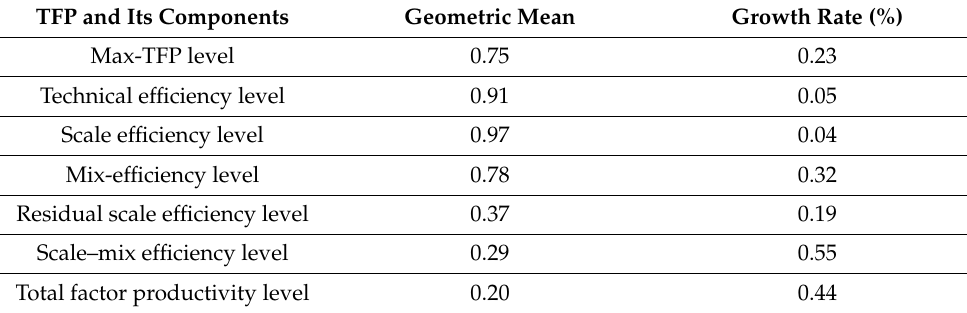
Table 2. Total factor productivity and efficiency levels in global